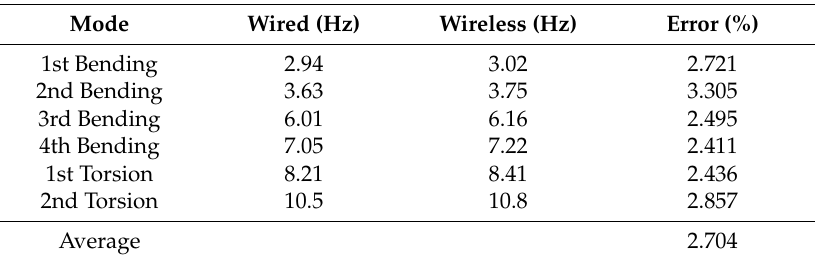
Table 3. Compare to natural frequency of model bridge (wired vs. wireless).